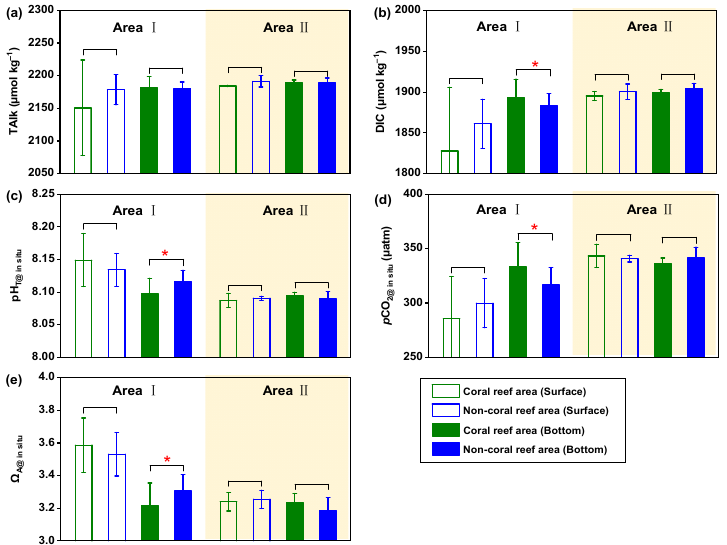
Figure A3. Distribution characteristics of temperature ( a , b ), salinity ( c , d ), DO ( e , f ) and Chl a ( g , h ), in the surface and bottom water of Dalu Bay (Area Ⅱ ).